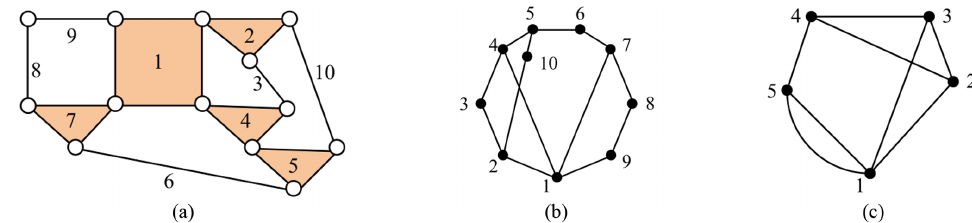
Figure 1. (a) A 10-link 1DOF KC, (b) topological graph, and (c) contracted graph.